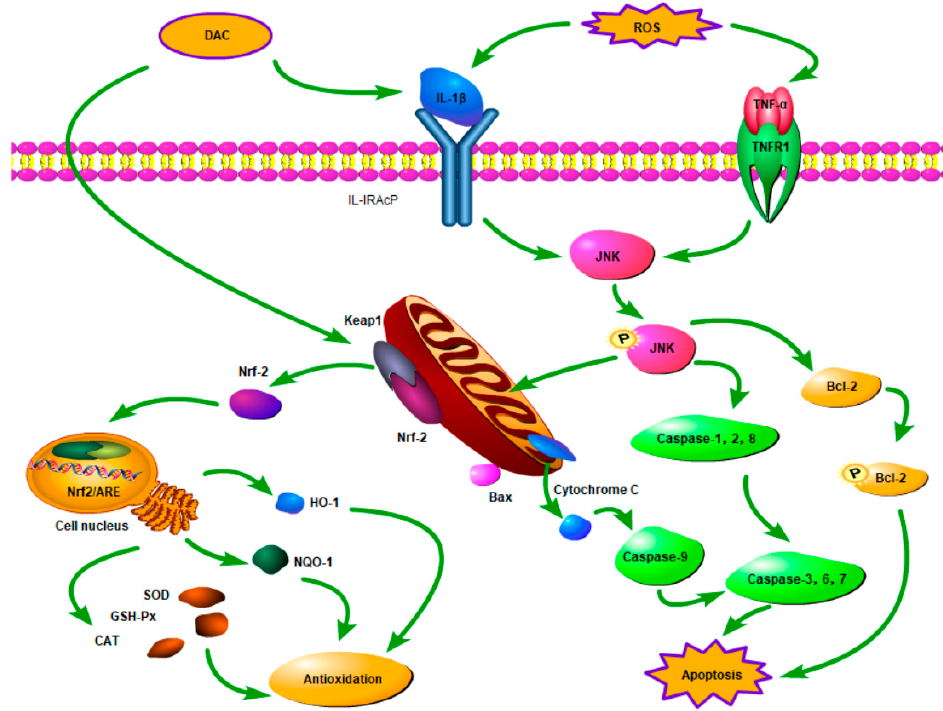
Figure 5. On the basis of above experimental results, the possible mechanisms of GMEC regulating its antioxidant capacity were mapped.